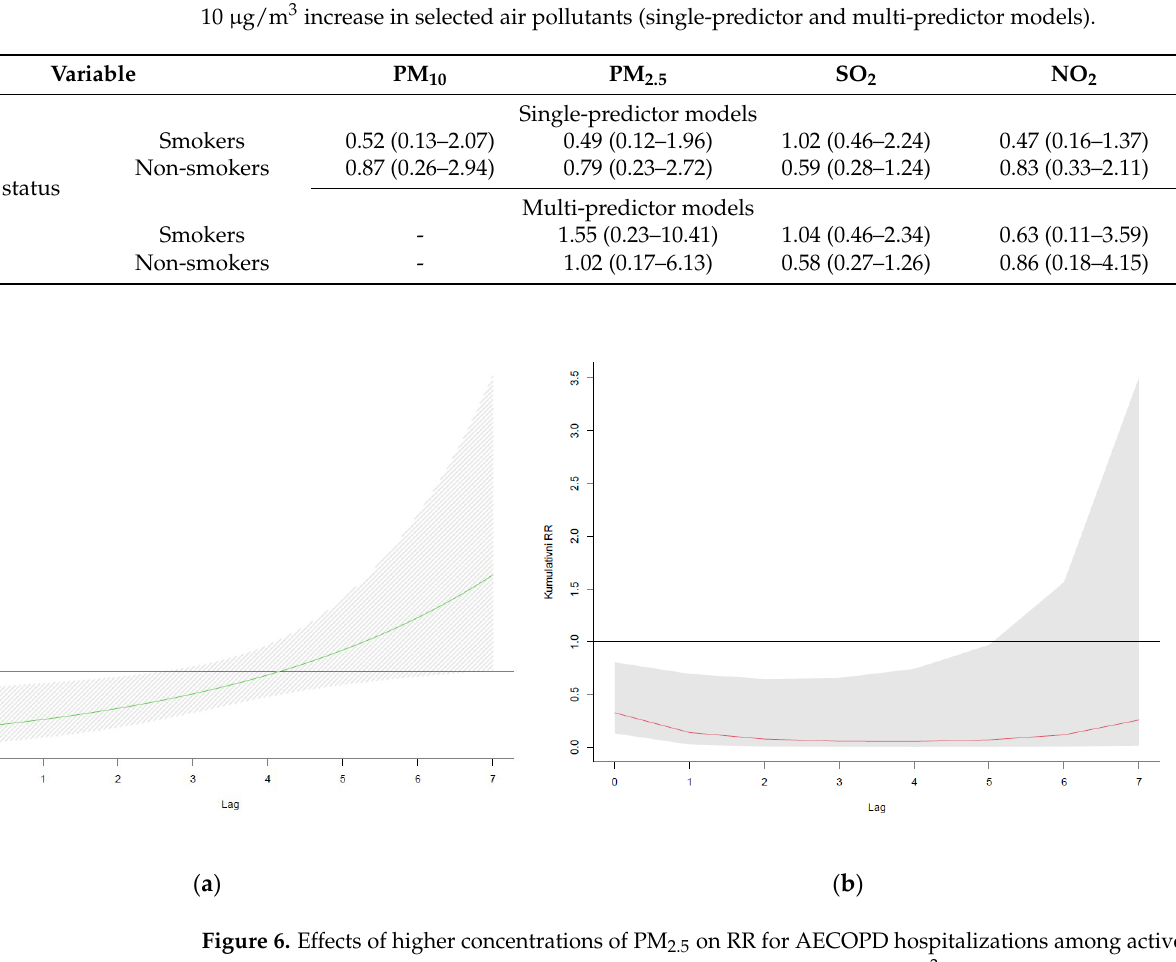
Table 4. Cumulative RR (lags0–7) with 95% CI in parentheses of AECOPD hospitalization for each 10 µ g/m 3 increase in selected air pollutants (single-predictor and multi-predictor models).